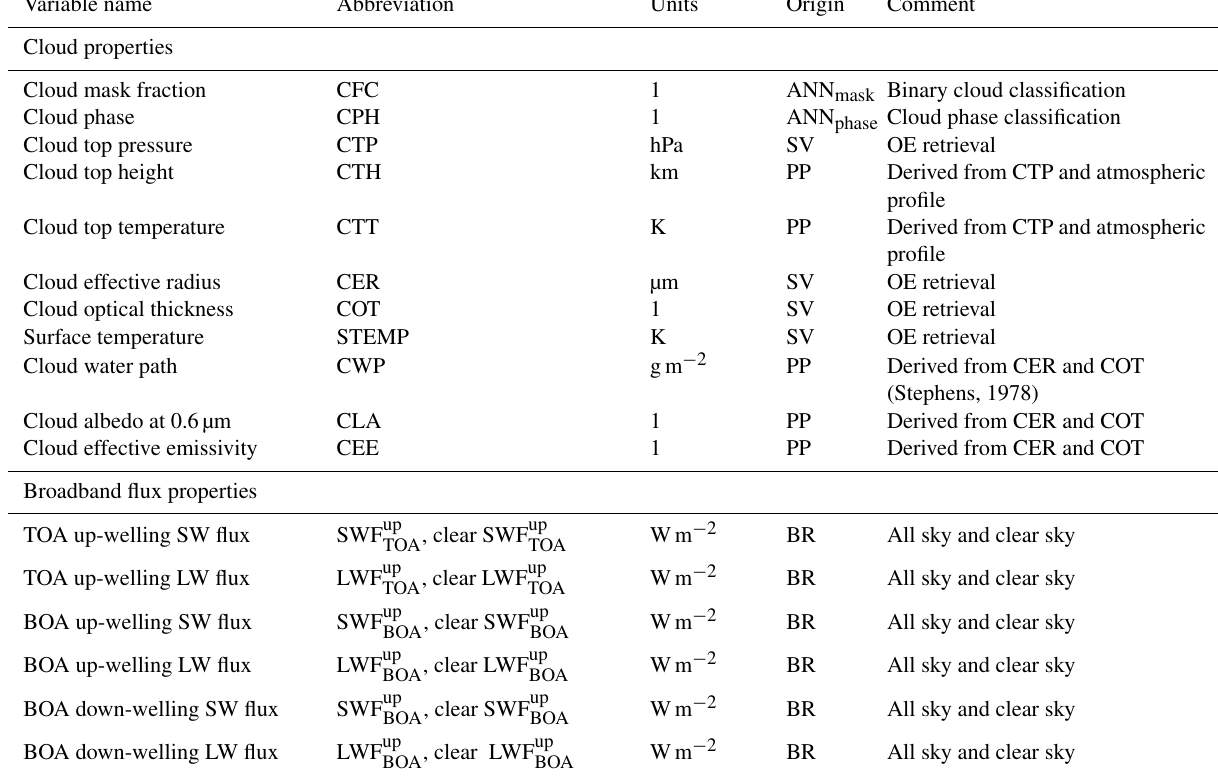
Table 2. Cloud_cci ATSR-2/AATSR cloud and radiation properties. ANN mask is the Artificial Neural Network for cloud detection, ANN phase is the Artificial Neural Network for cloud phase, SV is the state vector, PP stands for post-processed, OE stands for optimal estimation, BR is BUGSRad (a radiative flux algorithm), TOA stands for top-of-atmosphere, BOA stands for bottom-of-atmosphere (i.e. the surface), LW stands for longwave, SW and stands for shortwave. The upper part of the table has been adapted from Sus et al.